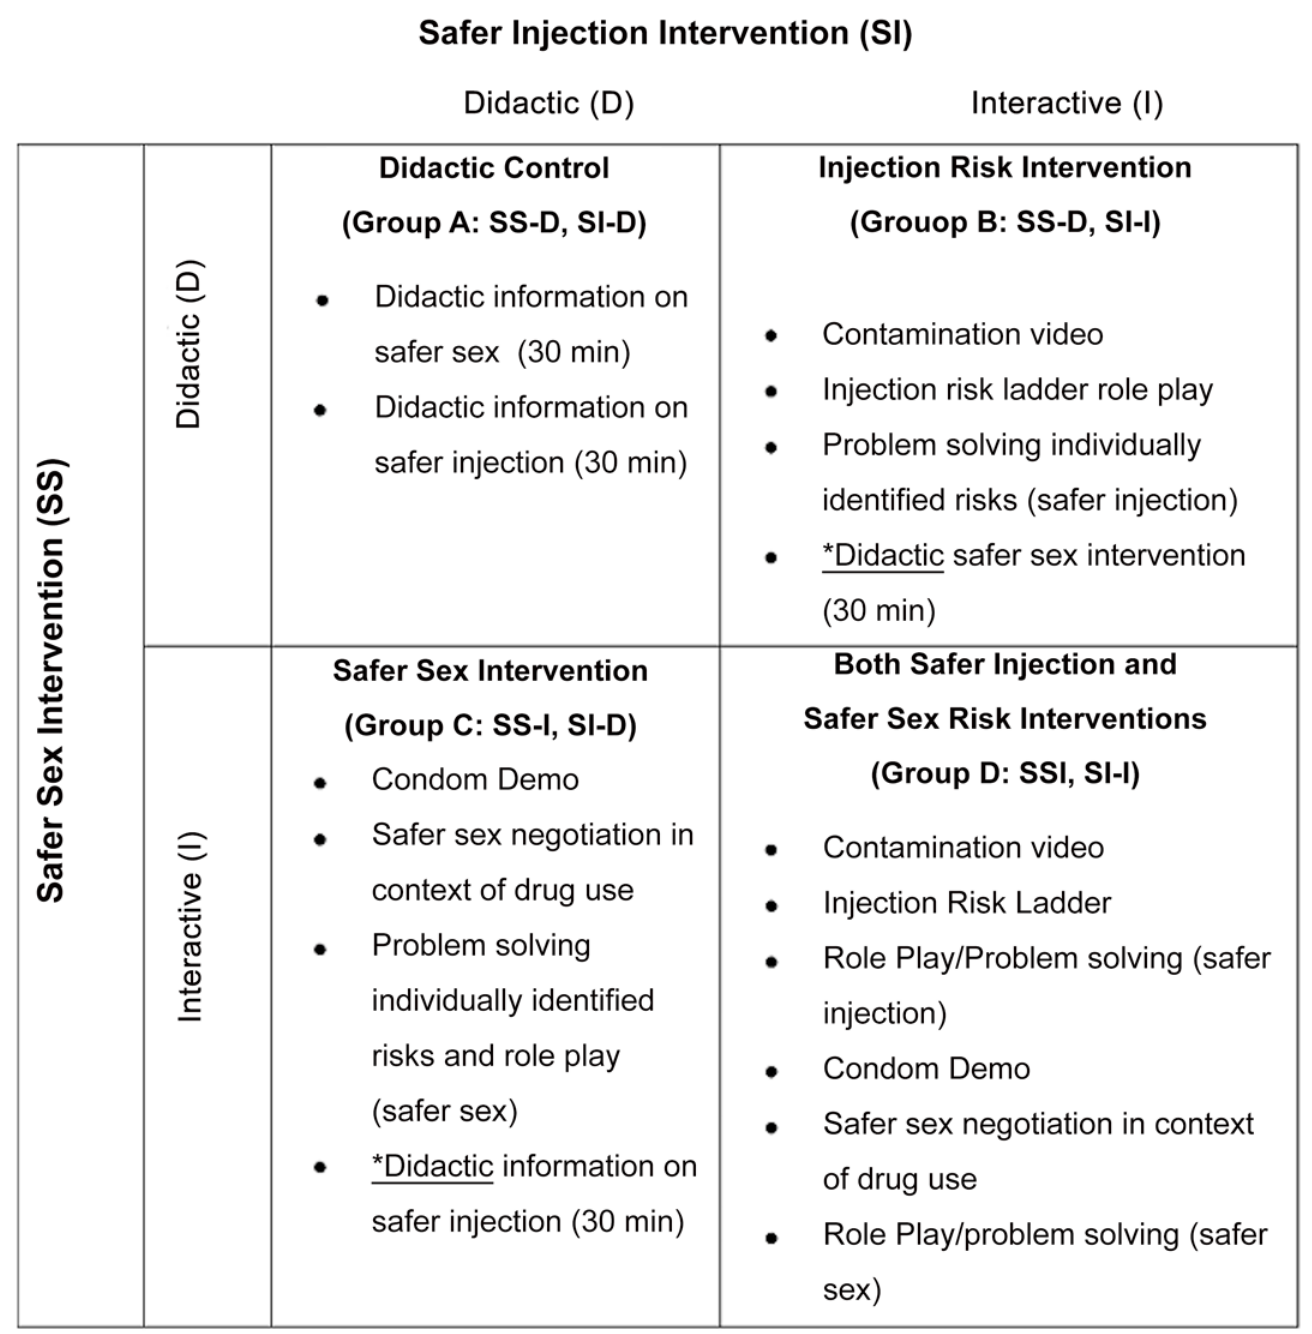
Fig 1. Mujer Mas Segura trial Design of 2x2 Factorial Trial to Simultaneously Evaluate Injection and Sexual Risk Reduction Interventions 1 . 1 Adapted from Strathdee PloS ONE